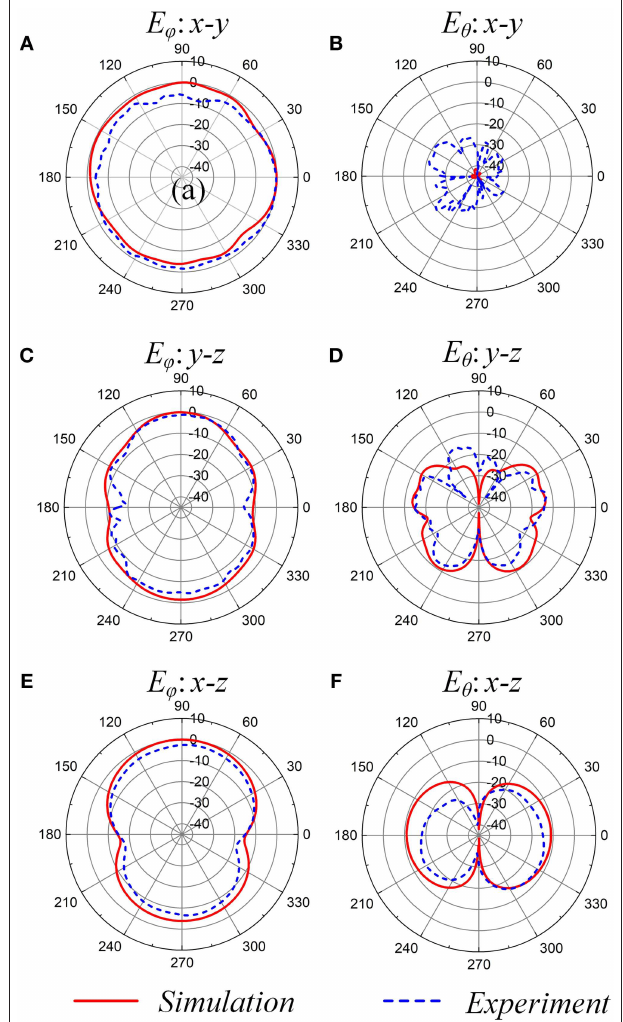
FIGURE 6 | Comparison of the far-field radiation patterns from the antenna between simulations and measurements. (A) E φ in x–y plane. (B) E θ in x–y plane. (C) E φ in x–z plane. (D) E θ in y–z plane. (E) E φ in y–z plane. (F) E θ in x–z